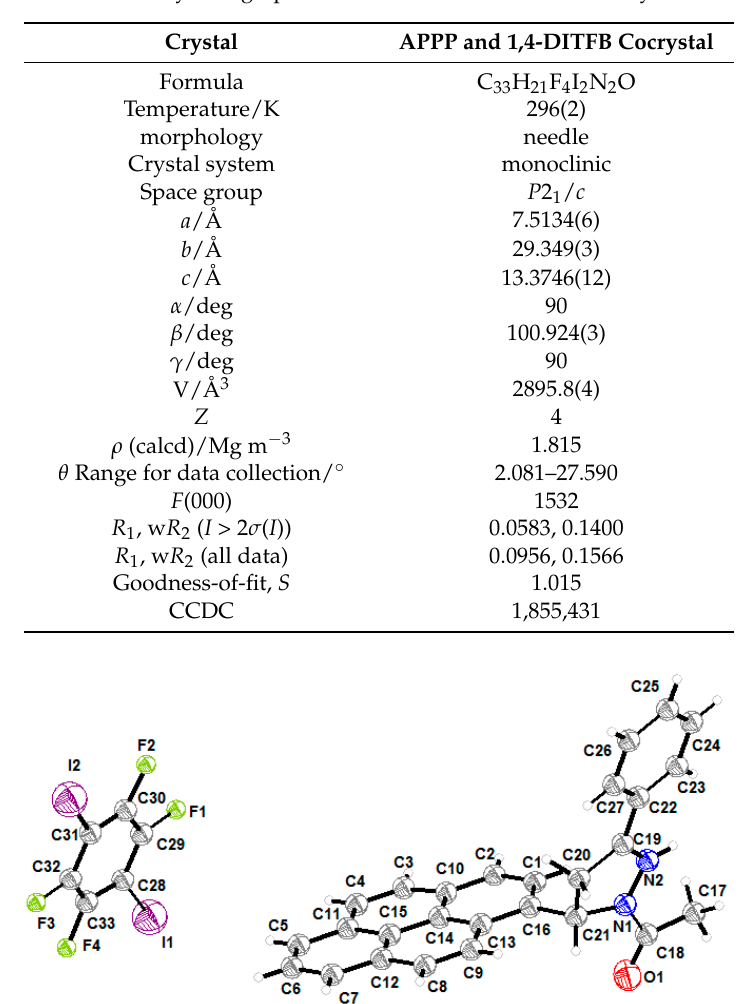
Table 1. Crystallographic data and refinement for the cocrystal.